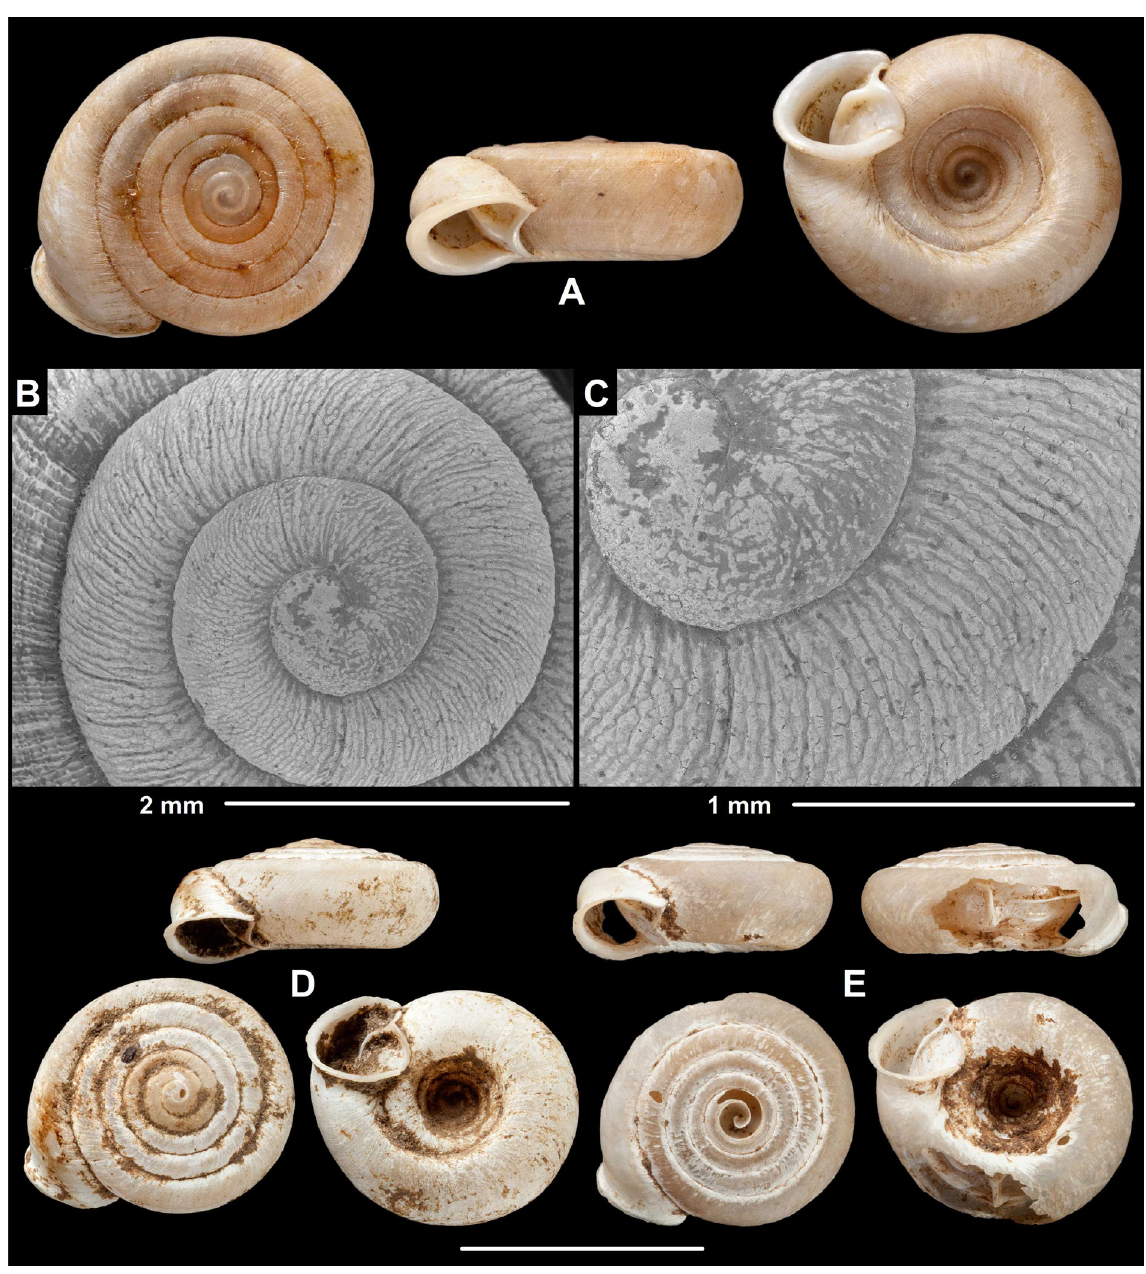
Fig. 18. Shells and protoconch of species of Chersaecia leiophis (Benson, 1860). A–C . Shells from Myanmar (NHMUK 1888.12.4.1526–1528, two different shells). D . Probable syntype of P. pseudophis Godwin-Austen, 1875 (NHMUK 1903.7.1.754). E . Syntype of P. kengtungensis Gude, 1914 syn. nov. (NHMUK 1903.7.1.750). Scale of shells = 10 mm. Images: B. Páll-Gergely (B–C) and H. Taylor (A,